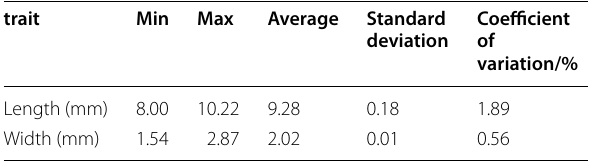
Table 1 Grain type phenotype survey